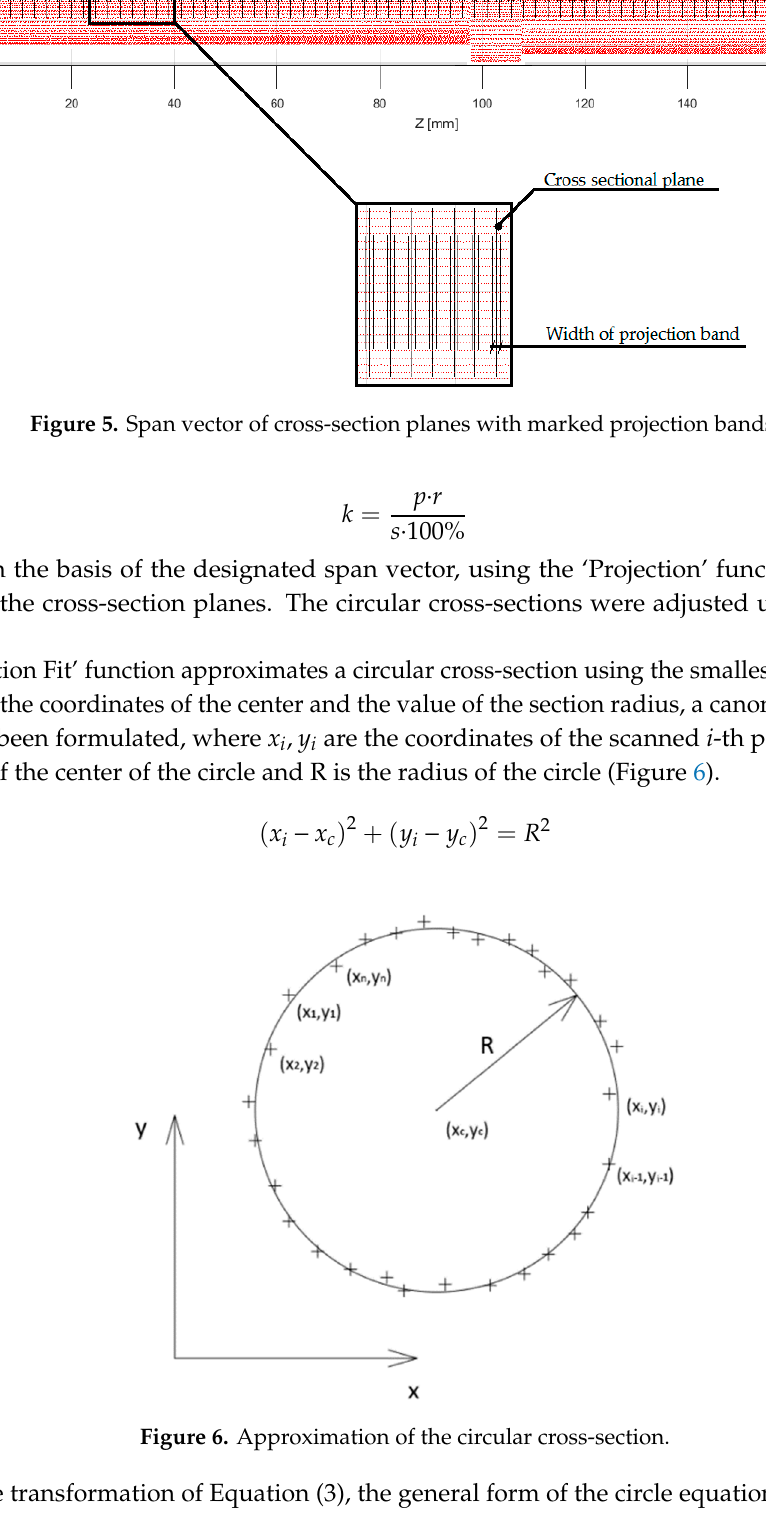
Figure 6. Approximation of the circular cross-section.